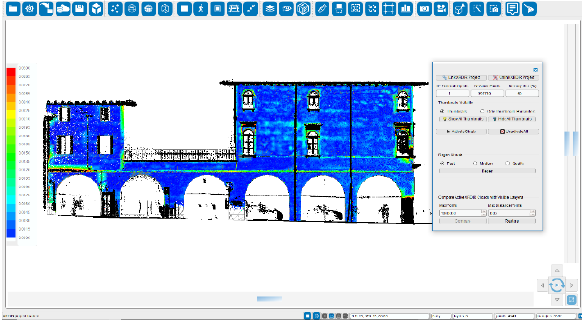
Figure 11. External wall: Advanced 3D vs TLS points cloud.